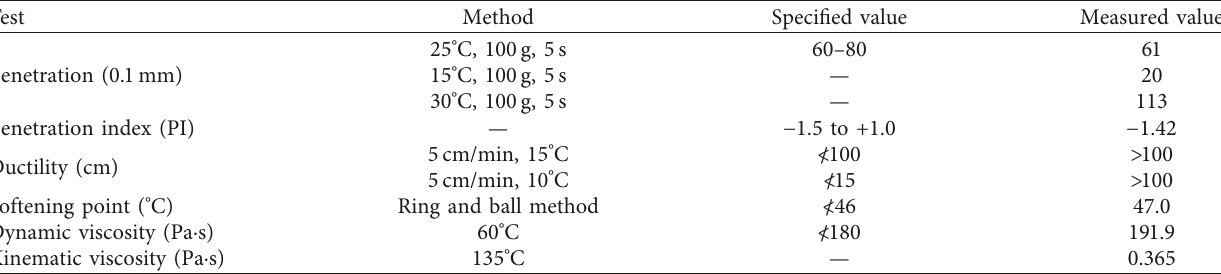
Table 1: No. 70 asphalt test